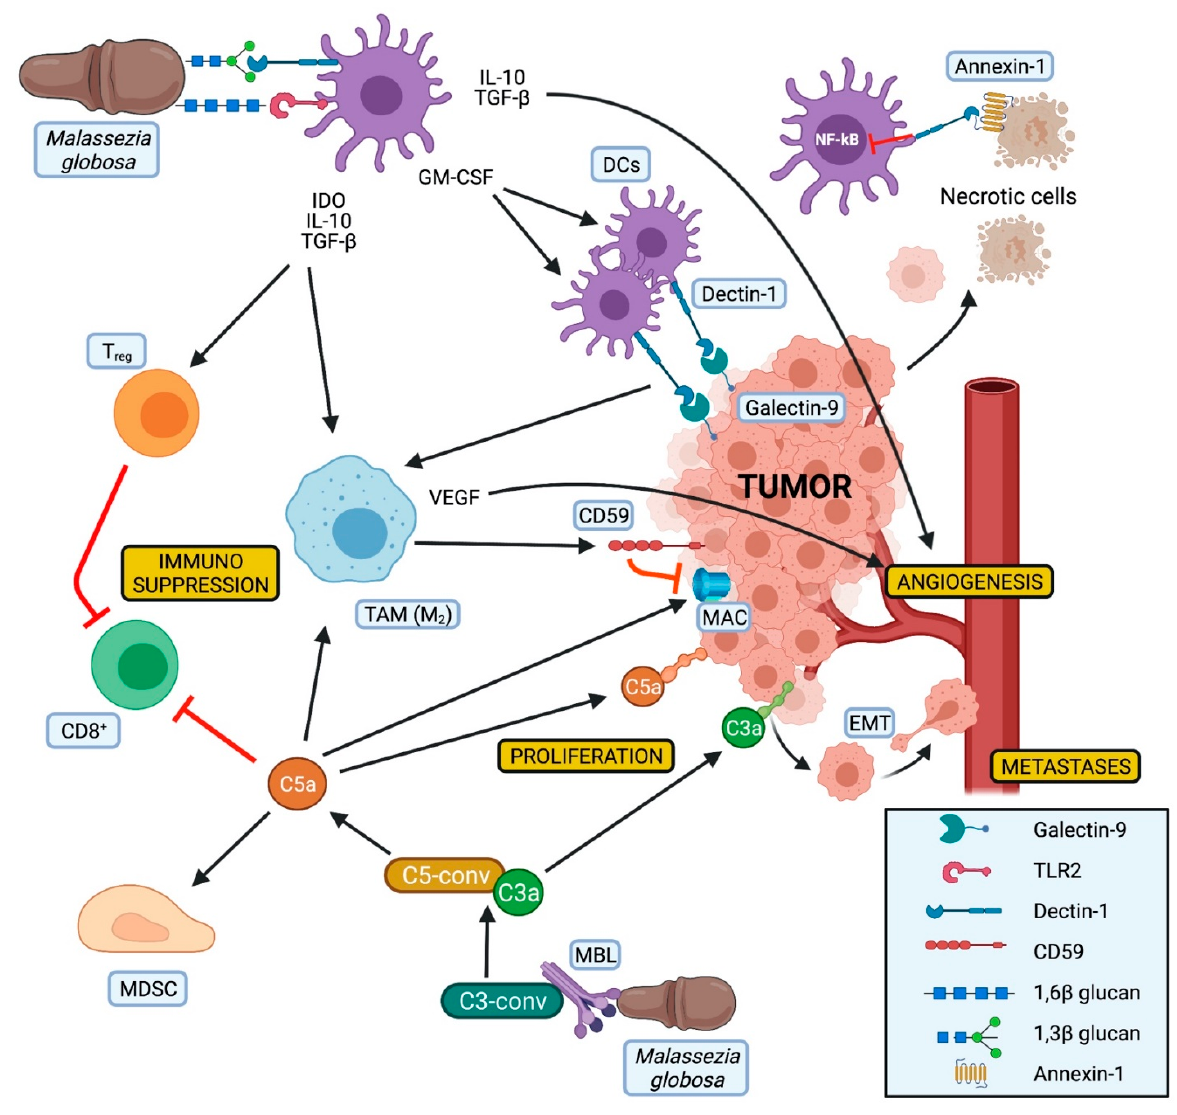
Figure 2. Proposed model of the role of Malassezia spp. in pancreatic tumor progression. The relation between Malassezia and pancreatic tumor progression is linked to the action of both cellular and molecular effectors, which lead to an intratumoral immune shaping. (1) Dendritic-cells (DCs): the synchronous recognition of fungal antigens like 1,3- and 1,6- β glucan by DCs lead to the production of GM-CSF [89], with consequent cell-expansion and release of indoleamine 2,3- dioxygenase (IDO), IL-10, and TGF- β . These mediators favor the activation of T reg , which inhibit T-cells cytotoxicity (CD8 + ) and stimulate a switch of tumor-associated macrophages (TAM) towards an M2-phenotype [90]. On the other hand, IL-10 and TGF- β , together with VEGF produced by the TAMs, stimulate the intratumoral angiogenesis. Thanks to the expansion of DCs, more Dectin-1 can bind Galectin-9, a lectin expressed on tumor cell membrane, and contribute to the M2-shift of the TAM [91]. Moreover, Dectin-1 can bind Annexin-1 on dying tumoral cells, leading to NF-kB inactivation [92,93]. (2) Complement system: the recognition of Malassezia through MBL activates the complement cascade, leading to formation of active C3 and C5 convertases. Among the different complement components, C3a and C5a both lead to tumor cell proliferation by binding their specific receptors expressed on PDAC cells. Furthermore, the signaling of C3aR increases the epithelial–mesenchymal transition (EMT), promoting the metastatic process. C5a acts in an immunosuppressive way by inducing apoptosis of CD8 + cytotoxic cells, attracting MDSC into the tumor, and participating in the shift of the macro- phages towards an M2-phenotype [87]. Of note, the fact that TAMs can induce the expression of CD59 on PDAC cells limits the antitumoral activity of the MAC. Abbreviations: C3-conv: C3-convertase; C5-conv: C5-convertase; CD8 + : cyto- toxic CD8 + T-cells; DC: dendritic cell; EMT: epithelial-mesenchymal transition; IDO: indoleamine 2,3-dioxygenase; MAC: membrane attack complex of the complement system; MBL: mannose binding lectin; MDSC: myeloid-derived suppressor cell; TAM: tumor associated macrophages M2 polarized; T reg : T-helper regulatory cell; VEGF: vascular endothelial growth factor. (Picture created in BioRender.com, https://biorender.com, accessed on 23 April 2021)